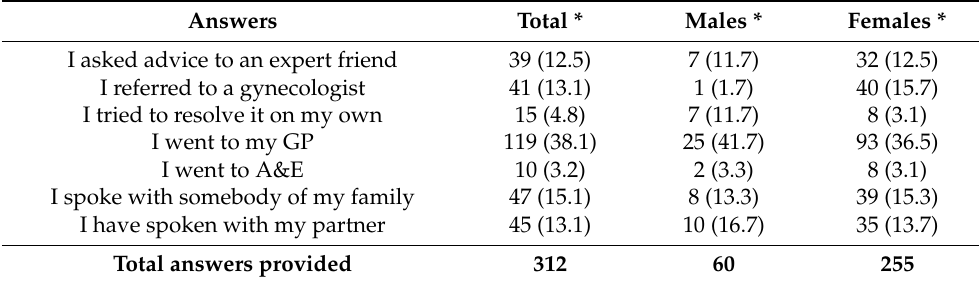
Table 4. Answer to the question: “ What have you done when you contracted a sexually transmitted infection in the past? ” Number and column percentage by